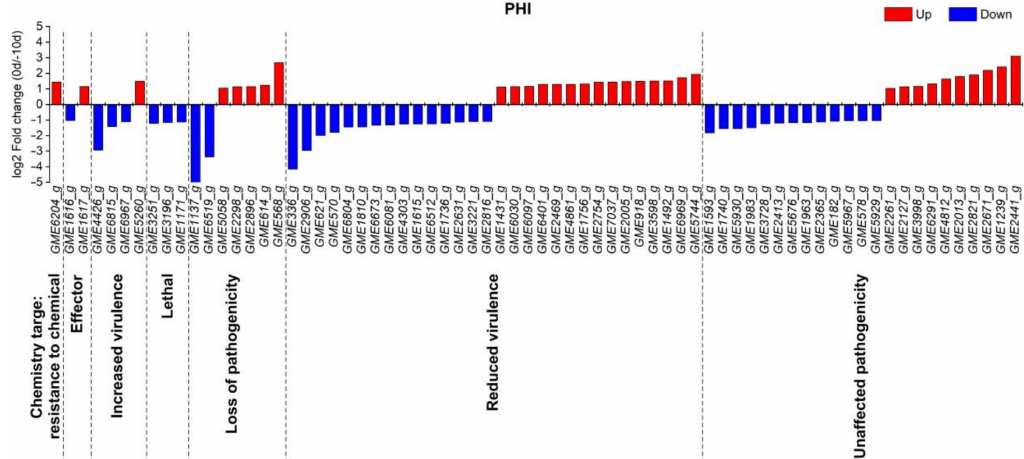
Figure 4. Prediction of pathogenicity-related genes based on the PHI database. Chemical target: resistance to a chemical, in which the mutation of the gene leads to resistance to certain drugs; Effector (plant avirulence determinant); Increased virulence, Hypervirulence; Lethal, the gene is necessary for the survival of the strain; Loss of pathogenicity, deletions of the gene do not cause disease; Reduced virulence, the deletion mutant is less virulent; Unaffected pathogenicity, the gene does not affect the pathogenicity of the